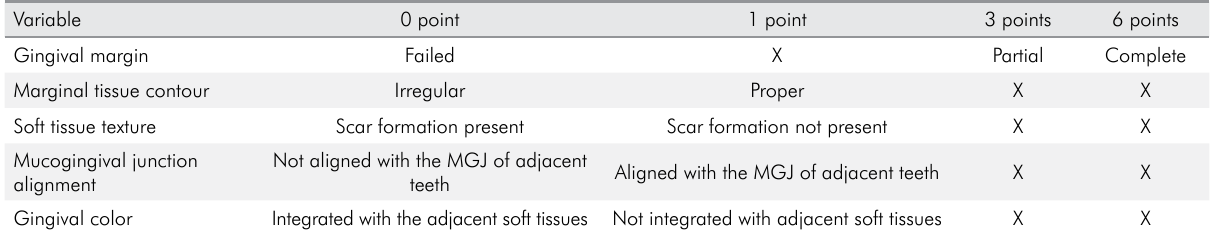
Table 1. Root coverage aestehtic scoring system (developed by Cairo et al. 16 ).